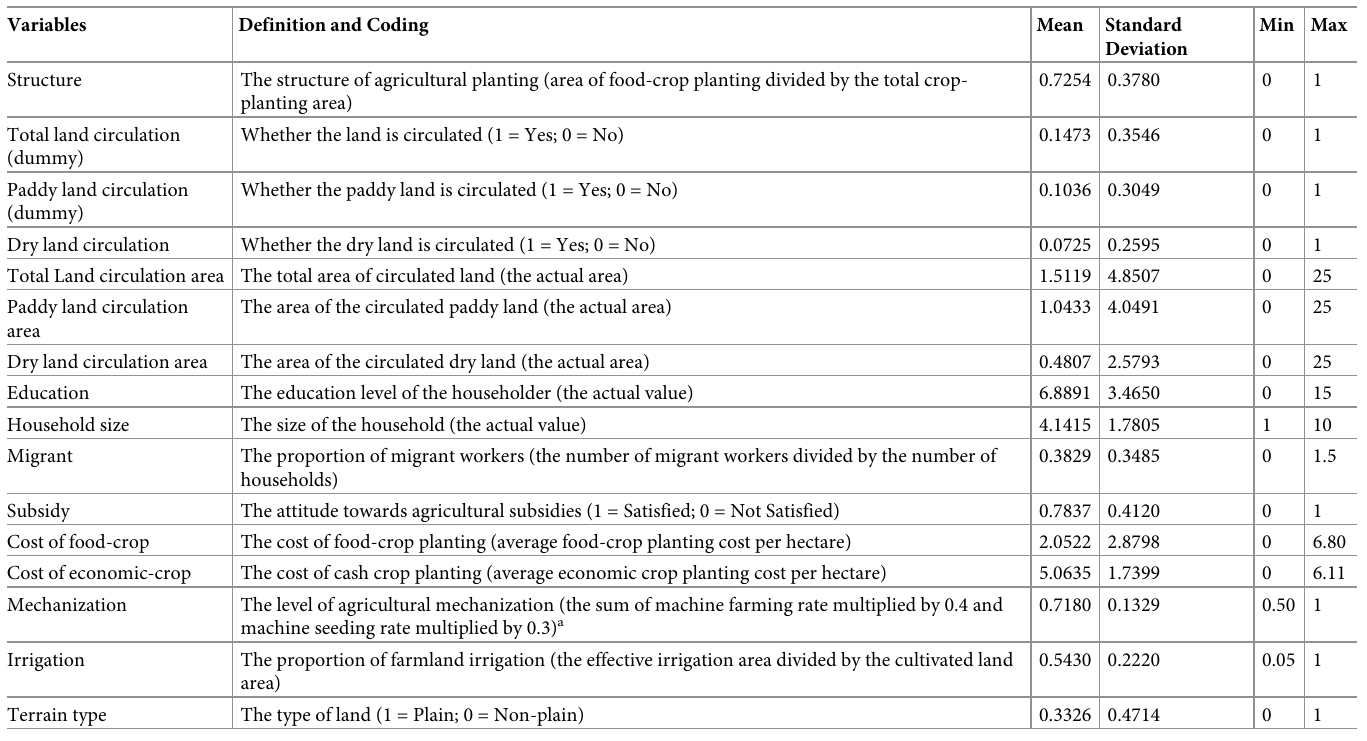
Table 1. Definitions of the variables and the